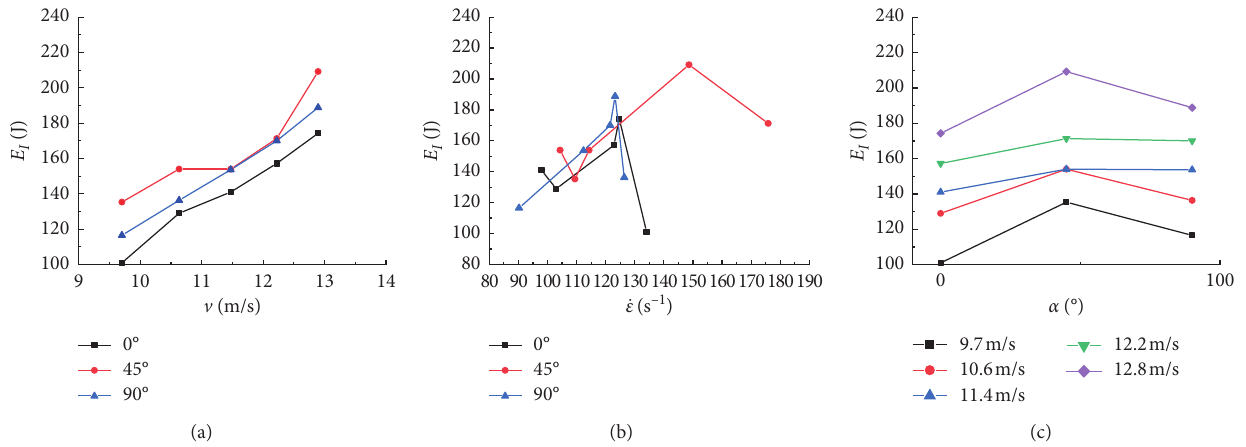
Figure 14: Relationship curves between incident energy and loading rate, prefabricated fracture angle, and strain